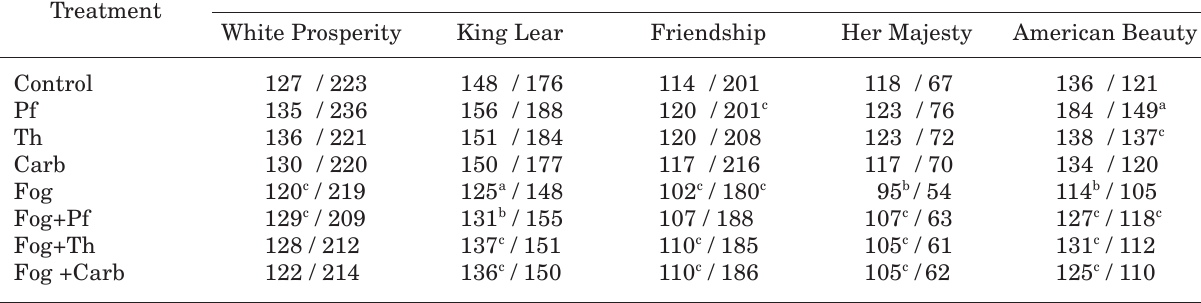
Table 2. Effect of application of Pseudomonas fluorescens (Pf), Trichoderma harzianum (Th) and carbendazim (Carb) on plant height and number of cormels of gladiolus cultivars grown in the soil with or without Fusarium oxysporum f. sp . gladioli (Fog)